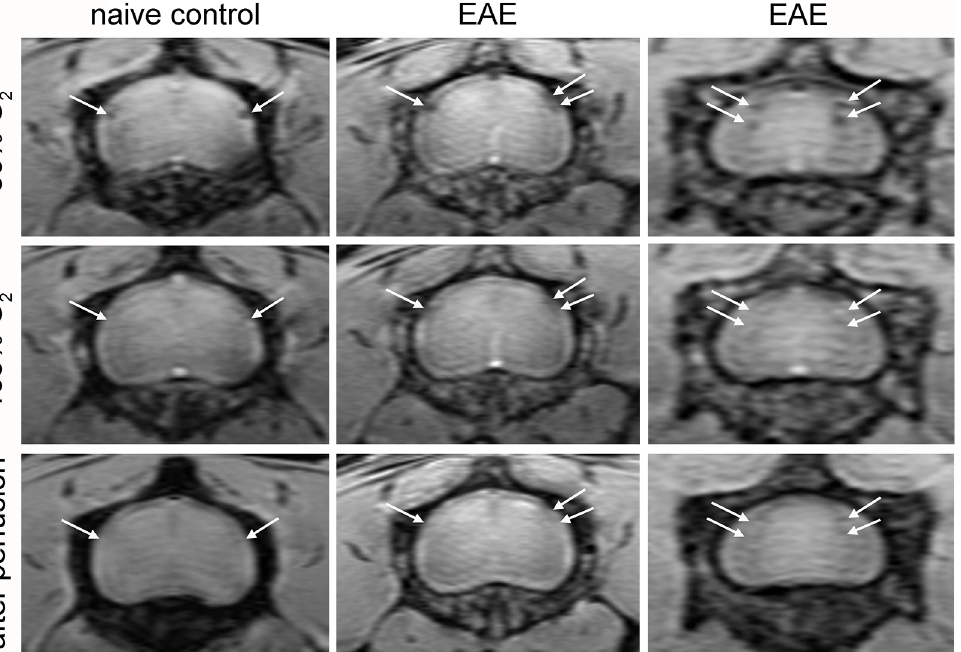
Fig 2. Hypointensities observed with 30% O 2 that change in appearance with 100% O 2 are not seen after perfusion. Left column: SWI MR images obtained in a naive control mouse where hypointensities visible with 30% O 2 disappear with 100% O 2 (white arrows). Middle and right columns: SWI MR images obtained in EAE mice, where hypointensities show different responses with 100% O 2 ; some disappear after perfusion (white arrows). As all hypointensities which changed with 100% O 2 disappear after perfusion, they are likely due to intravascular